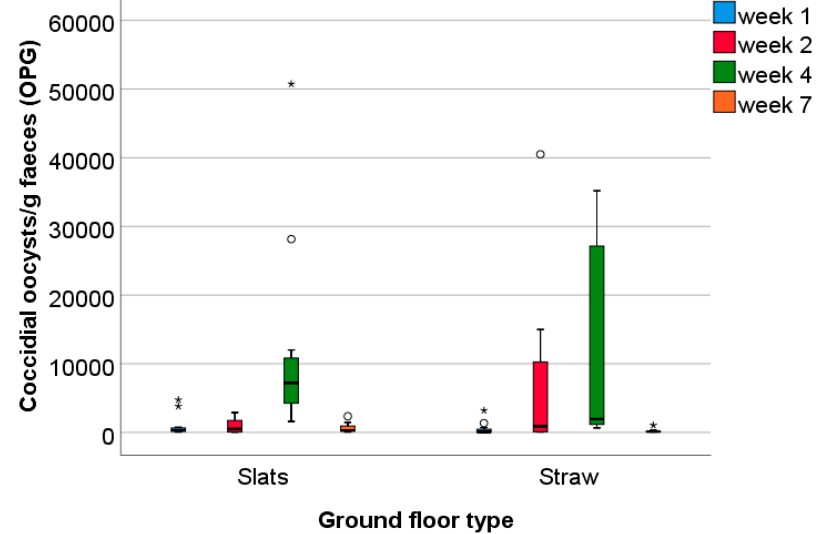
Figure 4. Number of coccidial oocysts/g faeces (OPG) in pens with the ground floor consisting